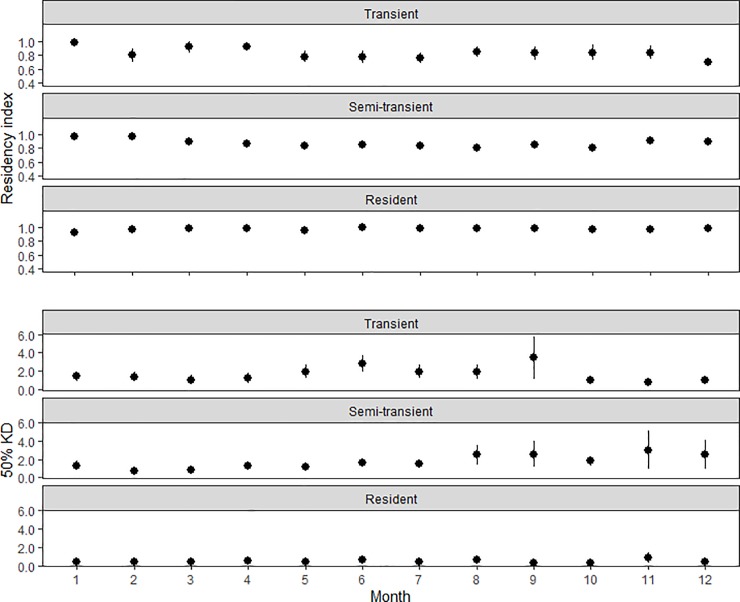
Kernel density and residency index estimates.Monthly 50% and 95% kernel density utilization (KD) and residency index (RI) estimates for all female grey reef sharks Carcharhinus amblyrhynchos monitored by acoustic array at Pohnpei and Ant Atoll from January 2010-October 2013. Error bars represent standard error. The outlined box represents the aggregation months.